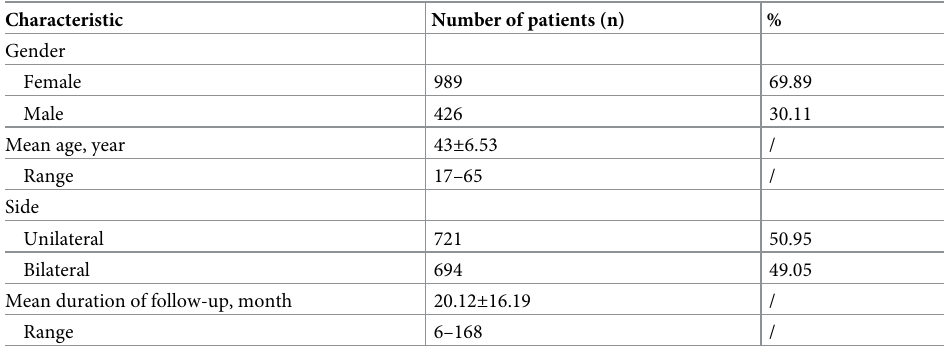
Table 1. Summary of patient characteristics.